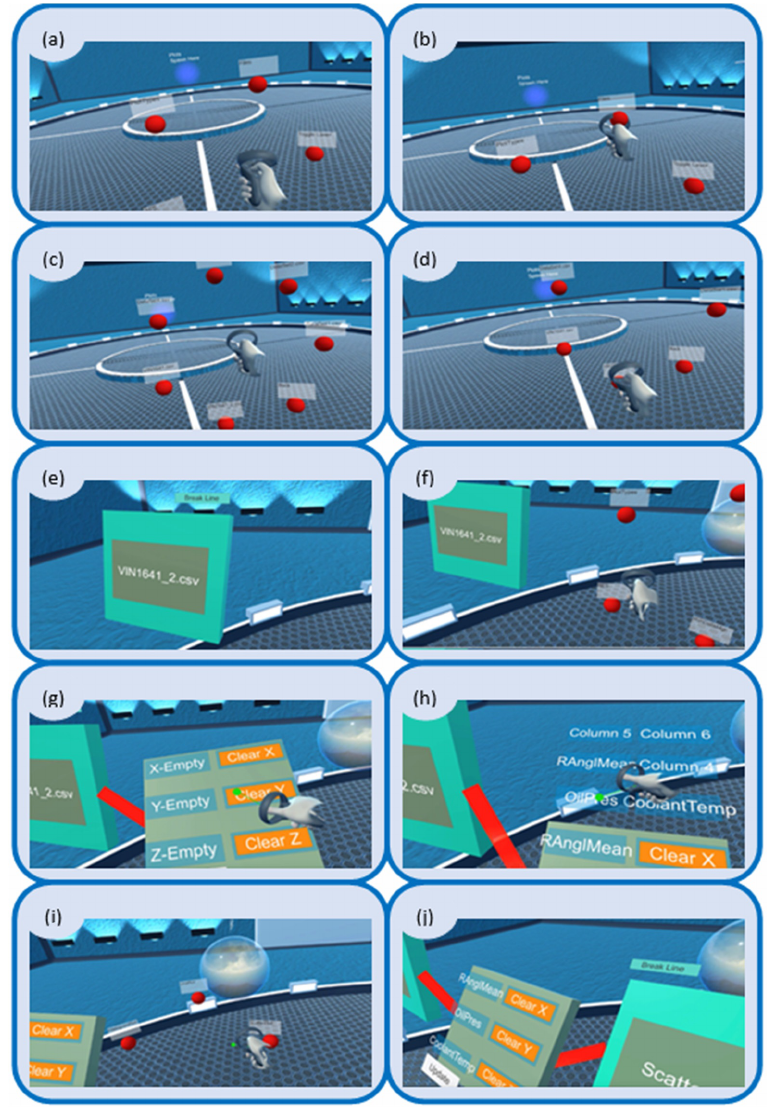
Figure 7. The successive steps leading to the generation of a visualization in IVEE. ( a ) IVEE’s menu system. ( b ) Selecting a database by touch. ( c ) Showing all files in the database. ( d ) Selecting a file by touch. ( e ) Virtual object represents the selected file. ( f ) IVEE’s sub menu system. ( g ) AES element. ( h ) Assigning different data attributes to desired axes. ( i ) Selecting the desired plot type. ( j ) Virtual object represents the plot type.